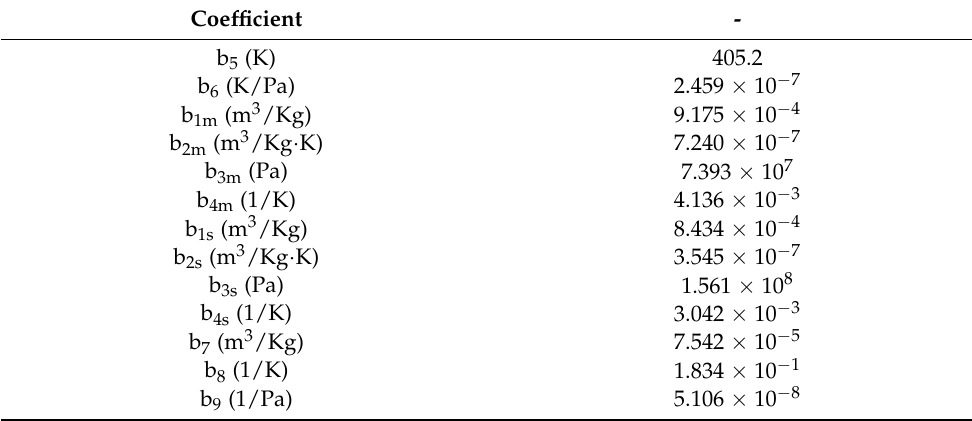
Figure 6. The PVT diagram measured by high-pressure capillary rheometer (in points) and calculated by 2-domain Tait equation (in lines). Table 3. Coefficients in 2-domain Tait equation for